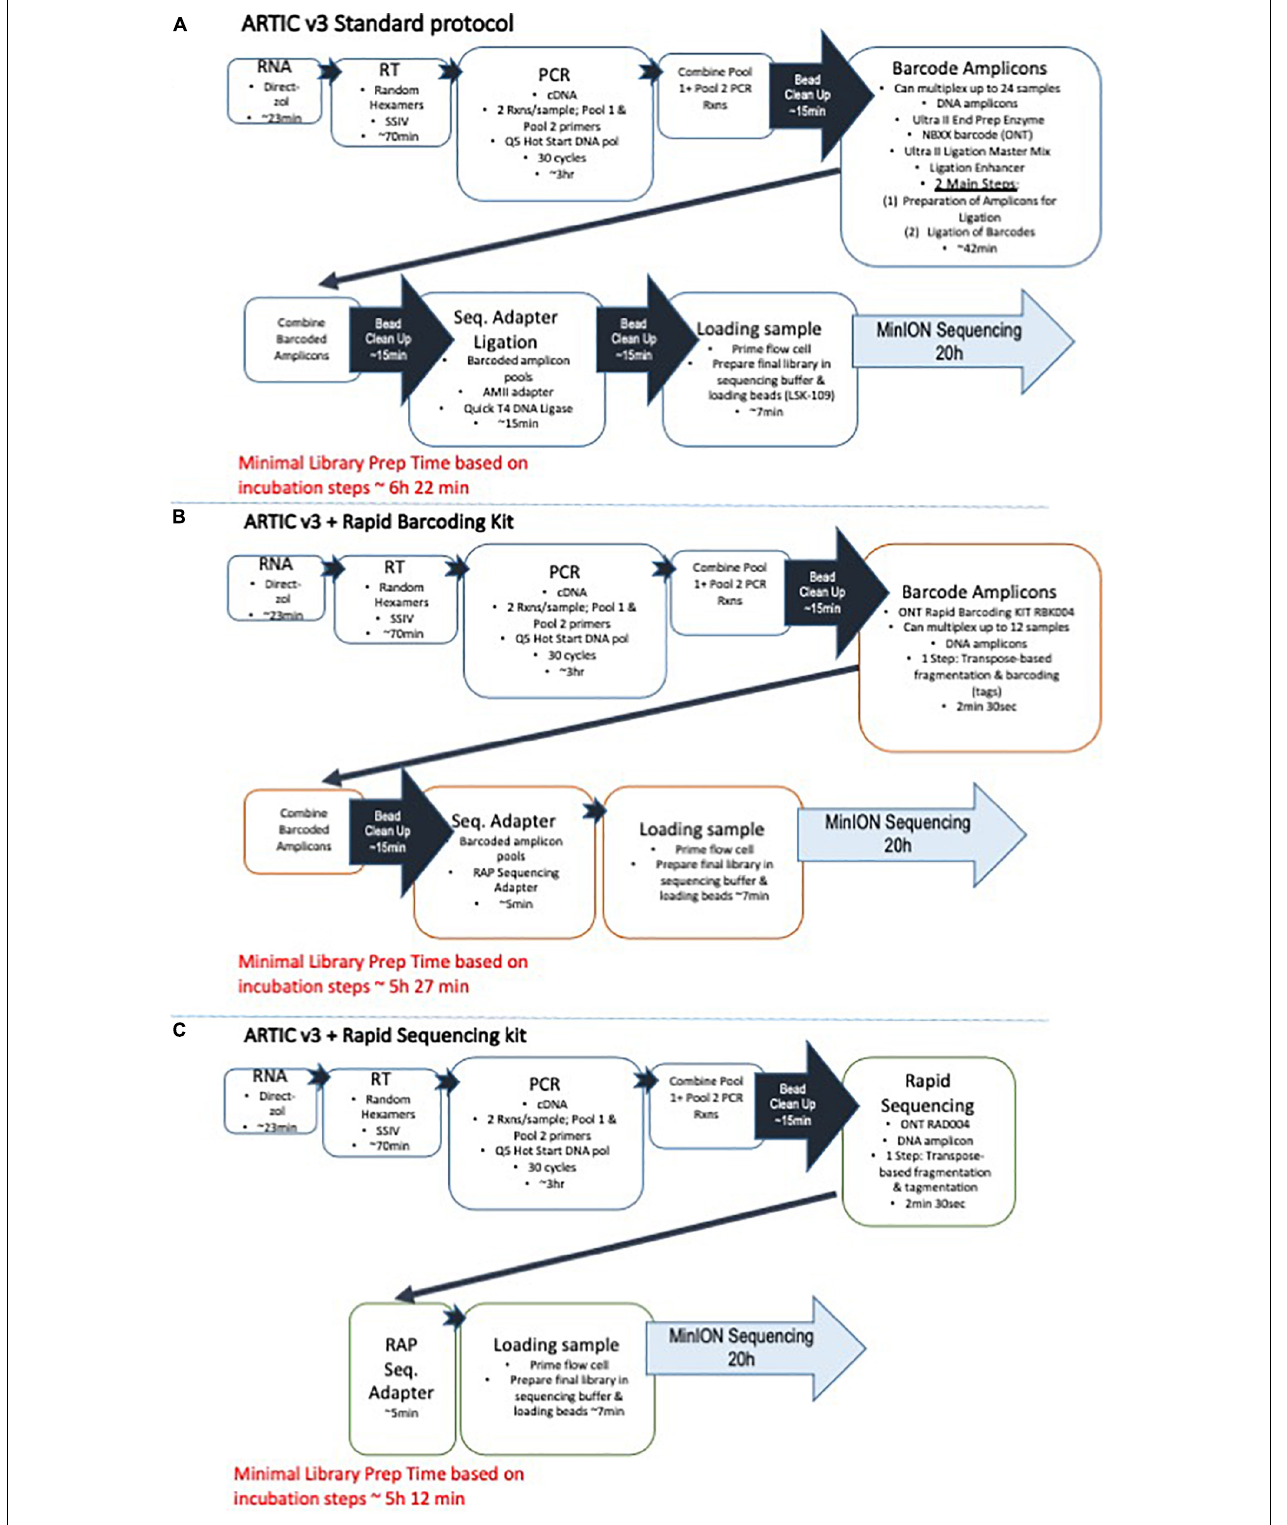
FIGURE 1 | Artic protocol and modified versions. Schematics for the COVID-19 sequencing workflows are shown starting with (A) the standard Artic protocol with v3 primers and followed by (B) the Artic protocol modified for use with the Rapid Barcoding Sequencing kit for multiplexed samples, and (C) the Artic protocol modified for use with the Rapid Sequencing kit for rapid sequencing of individual